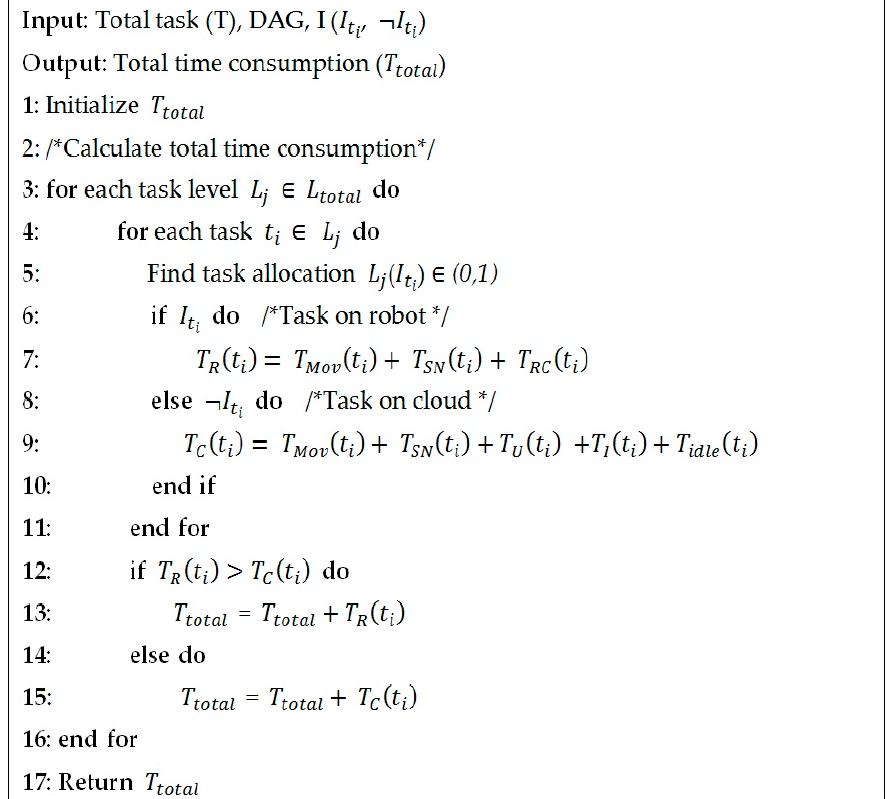
Figure 5. Pseudo-code for calculating the total task completion time/delay.